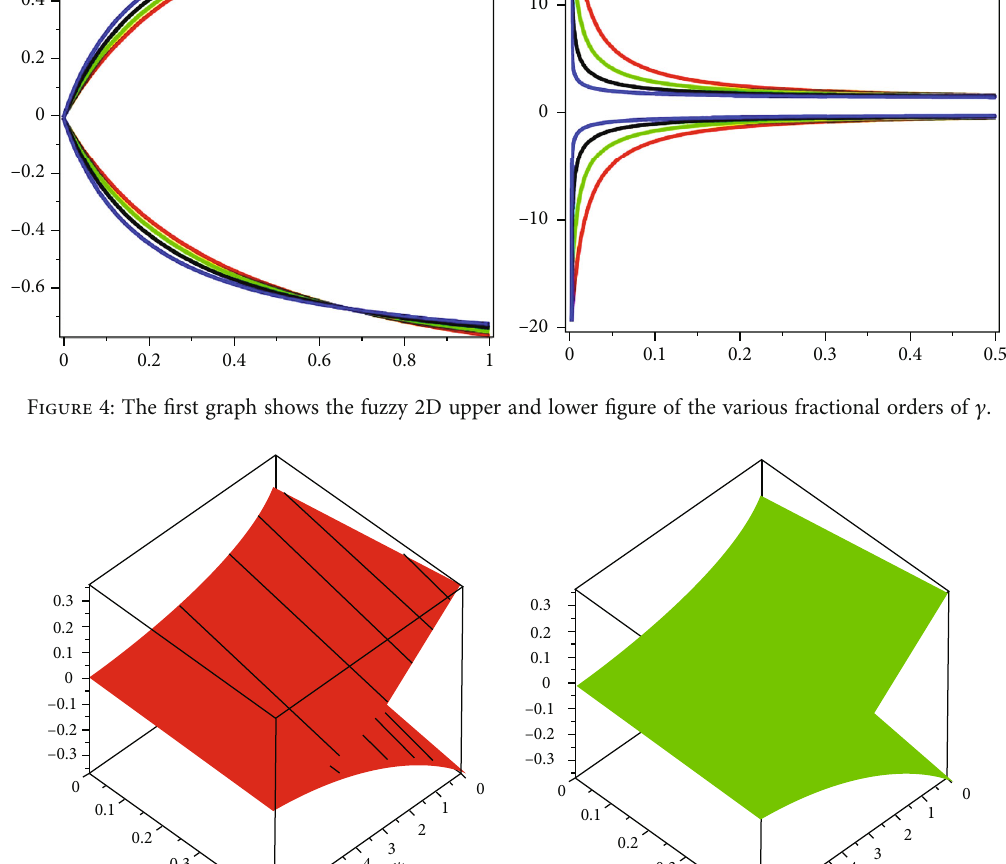
Figure 5: The fi rst graph shows the fuzzy 3D upper and lower fi gure of analytical solution at γ = 1 and the second graph at fractional of γ = 0 : 8 .